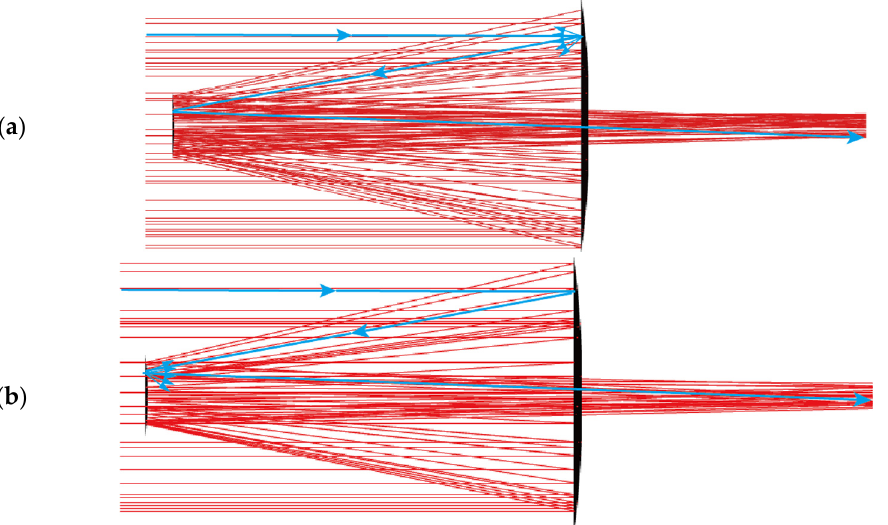
Figure 8. The paths of scattering that are from the primary ( a ) and the secondary ( b ) of the Cassegrain telescope.